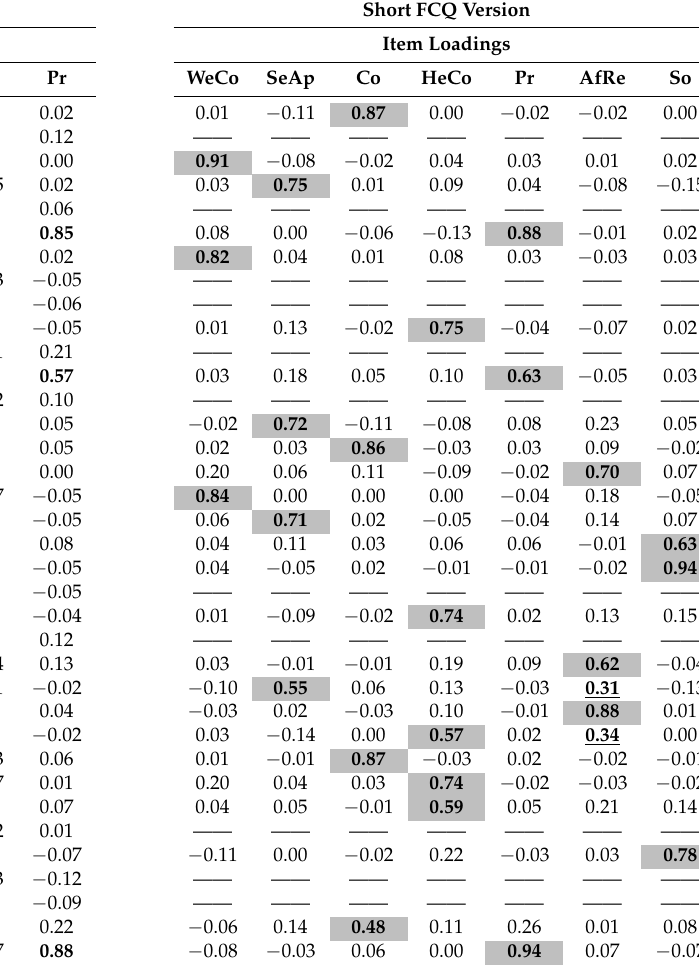
Table 2. Item loadings in the initial FCQ and Short FCQ and among factor